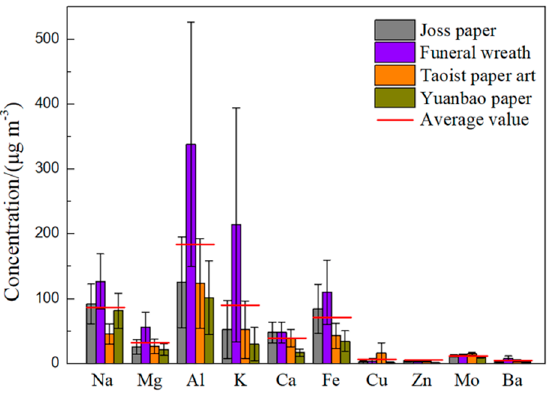
Figure10. ConcentrationsofelementsinthePM 2.5 generatedfromtheincinerationofsacrificialo ff Figure 10. Concentrations of elements in the PM 2.5 generated from the incineration of sacrificial offerings.